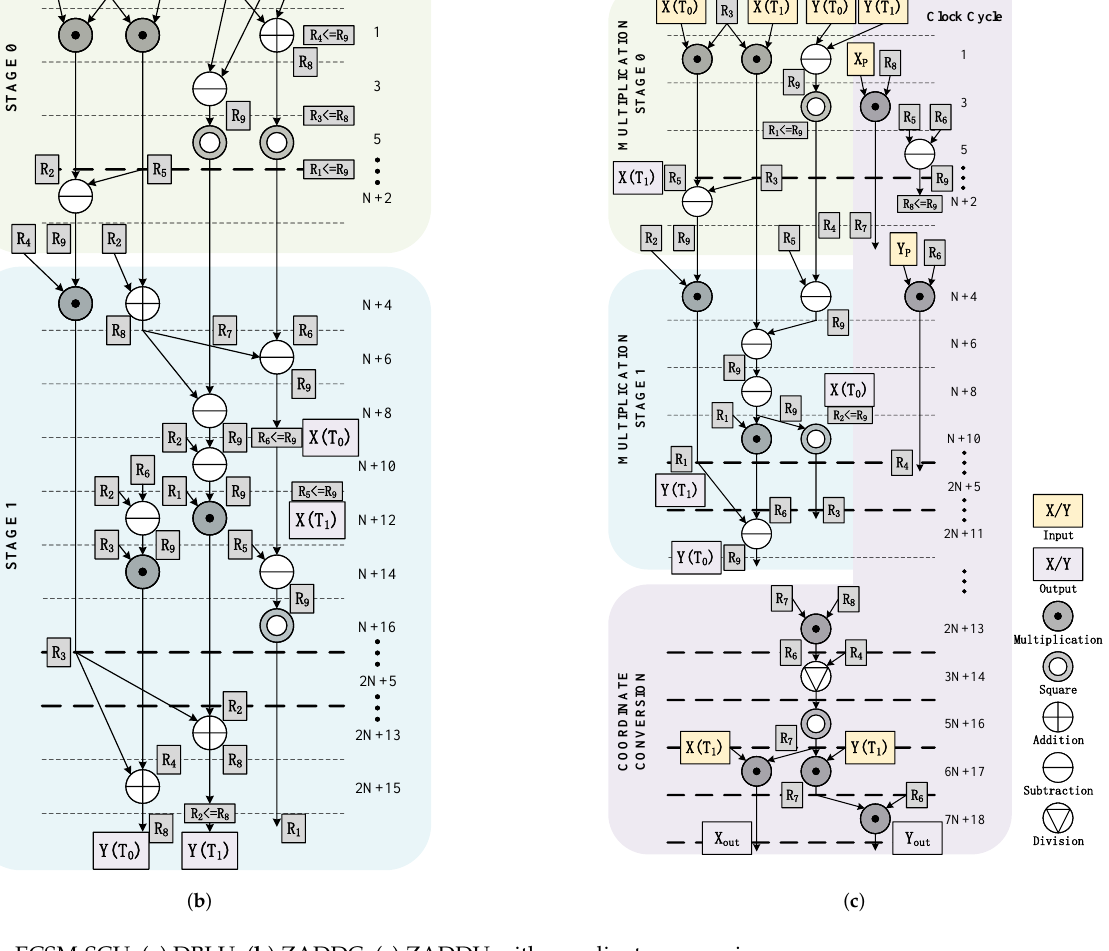
Figure 7. Co-Z arithmetic scheduling in ECSM-SCU. ( a ) DBLU. ( b ) ZADDC. ( c ) ZADDU with coordinate